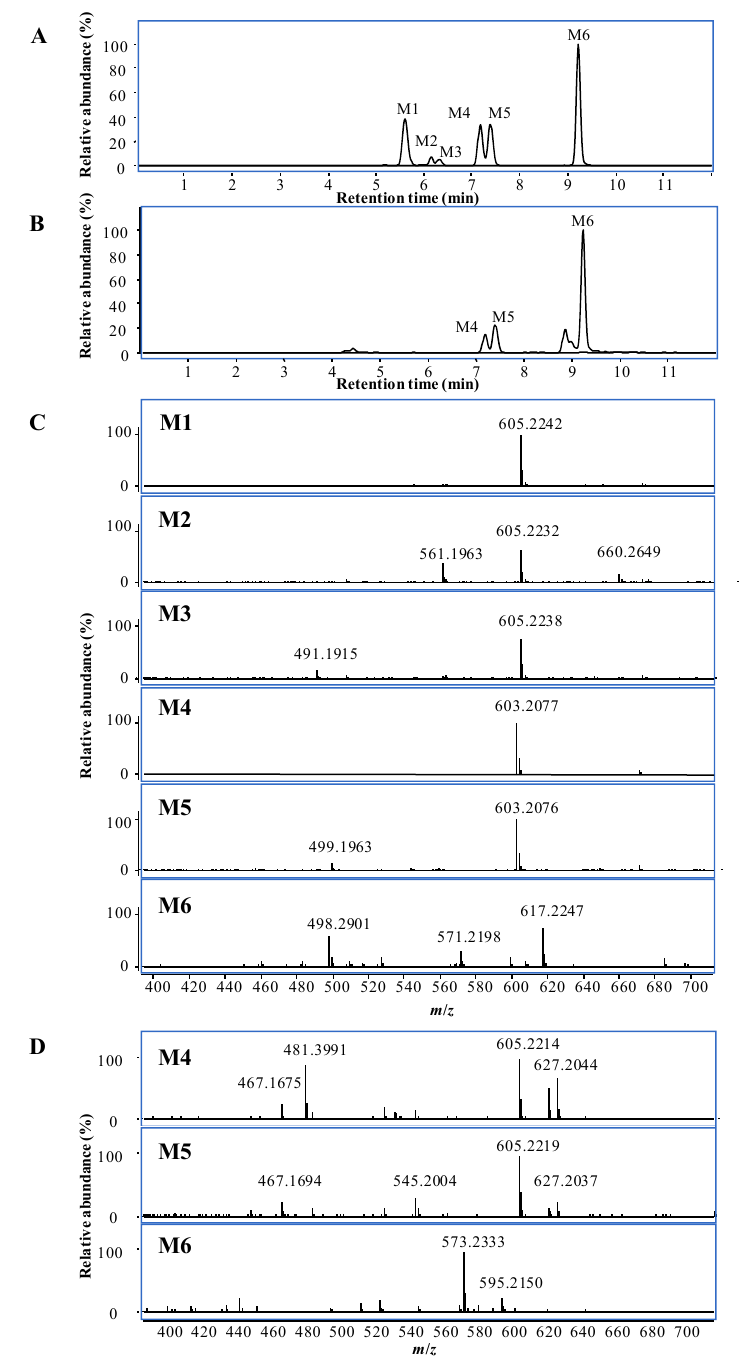
Figure 3. UHPLC-MS chromatogram of metabolites and their MS spectra in vitro at 20 min in negative mode ( A and C ) and positive modes ( B and D